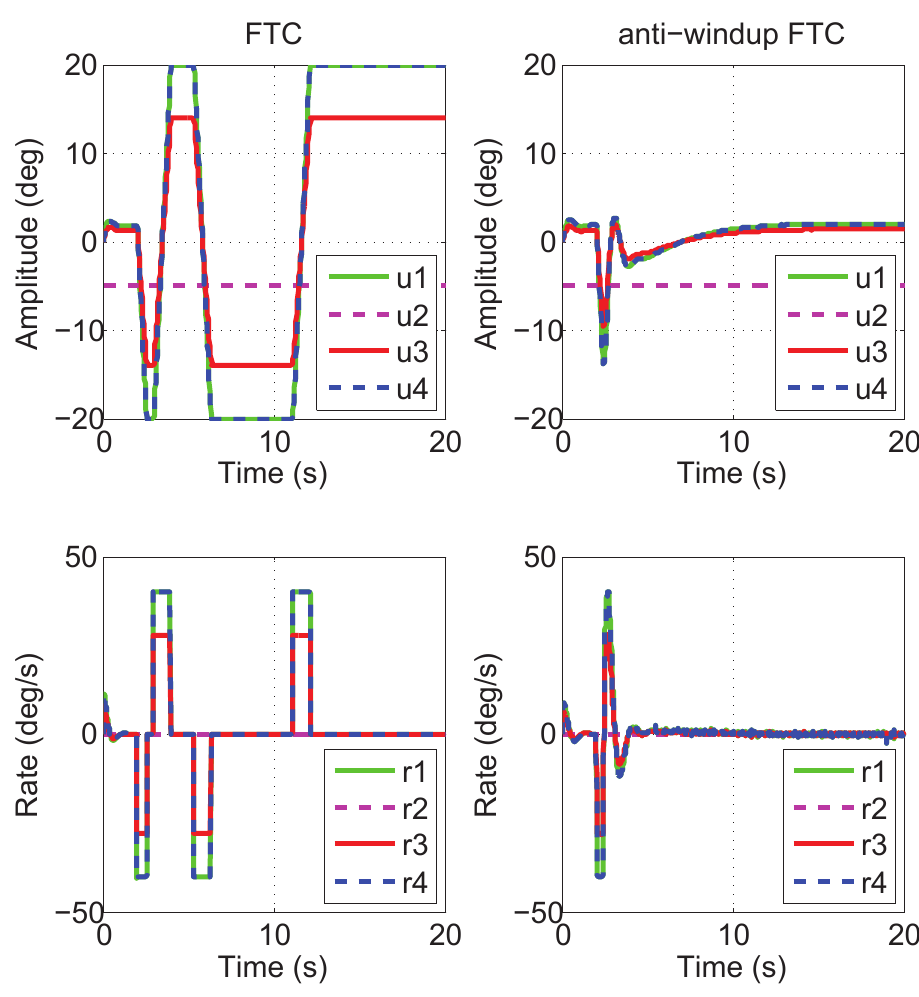
Figure 8. Actuator deflections and